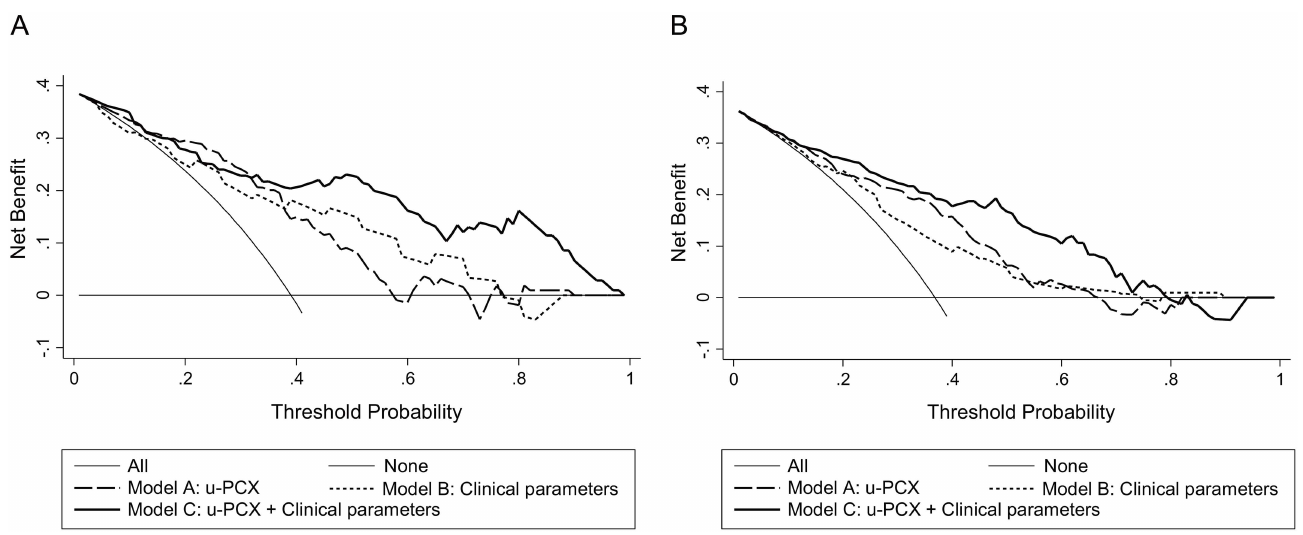
Fig 3. Decision curve analysis. (A) Trainingcohort. (B) Validationcohort.